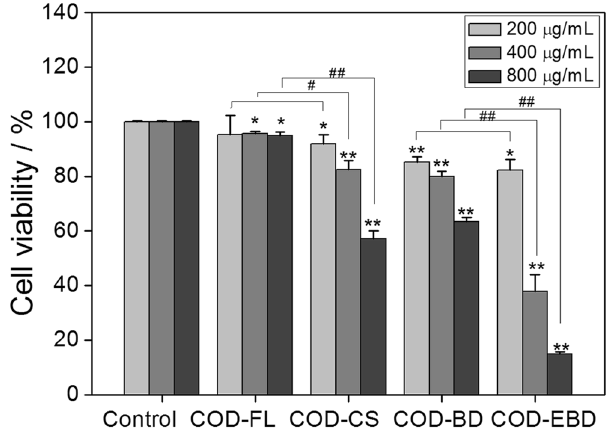
Figure 2. Cell viability detection by CCK-8 assay of HK-2 cells after exposure to different concentrations of COD with various shapes for 6 h. Compared with control group, * p < 0.05. ** p < 0.01. COD-FL treatment group vs corresponding concentration of COD-CS treatment group, COD-BD treatment group vs corresponding concentration of COD-EBD treatment group, # P < 0.05, ## P < 0.01.